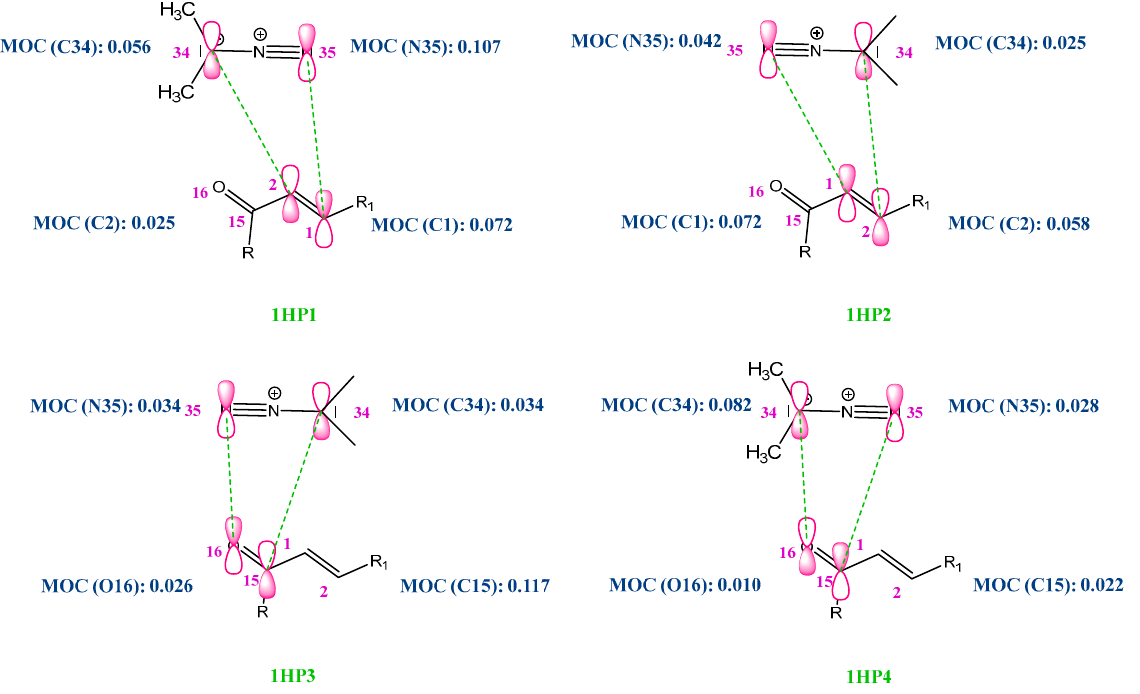
Figure 5. Molecular orbital coefficient values of different sites for the four predicted 1H P1-P4 TSs.